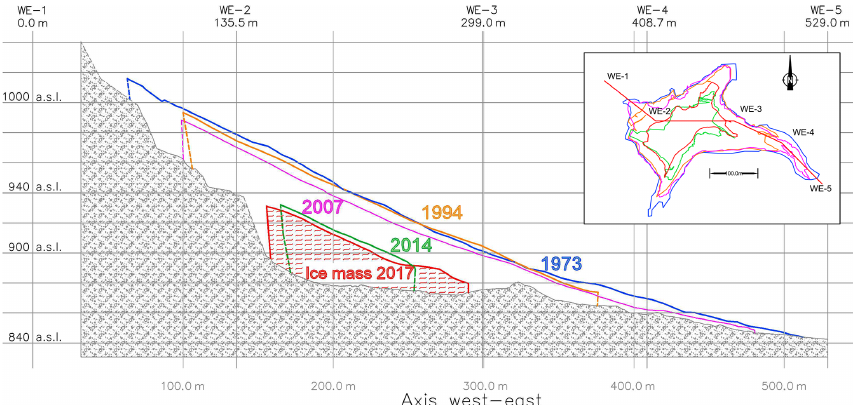
Figure 4. Surface profile of the Ice Chapel measured at the end of the ablation season of the respective years 1973, 1994, 2007, 2014, and 2017.